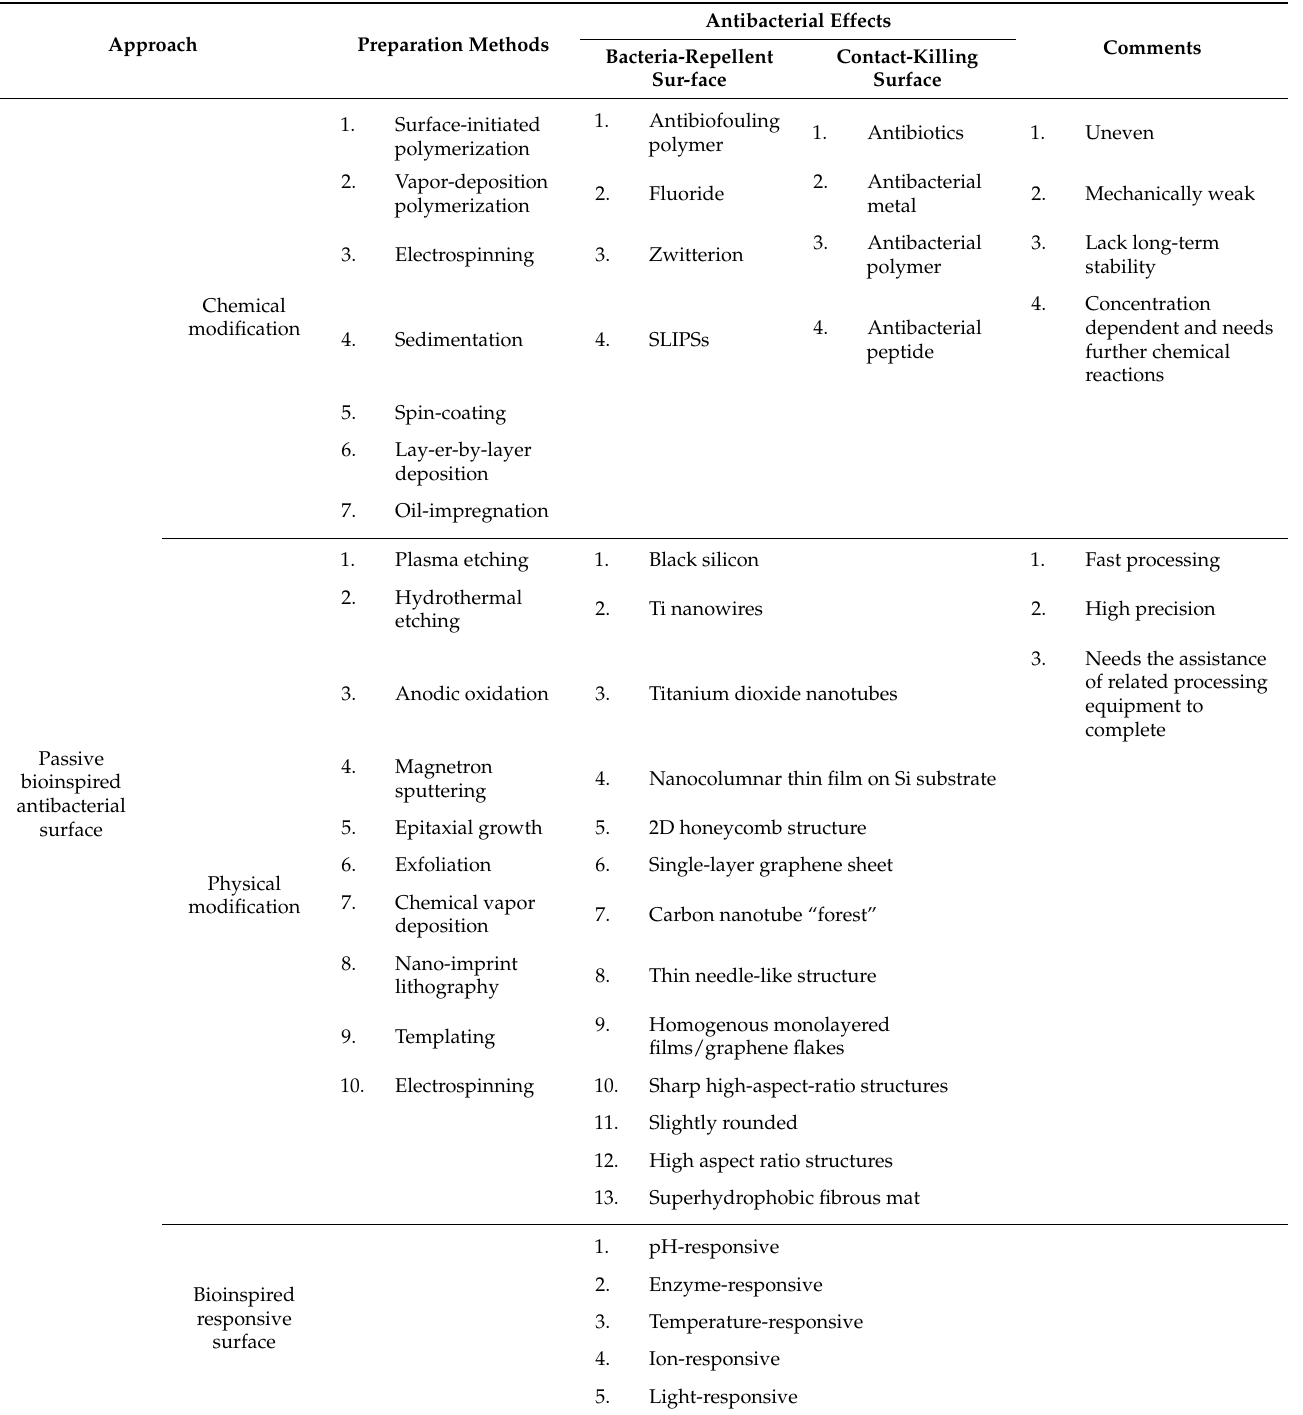
Table 1. Current surface-modification approaches in the design of passive bioinspired antibacterial surfaces.